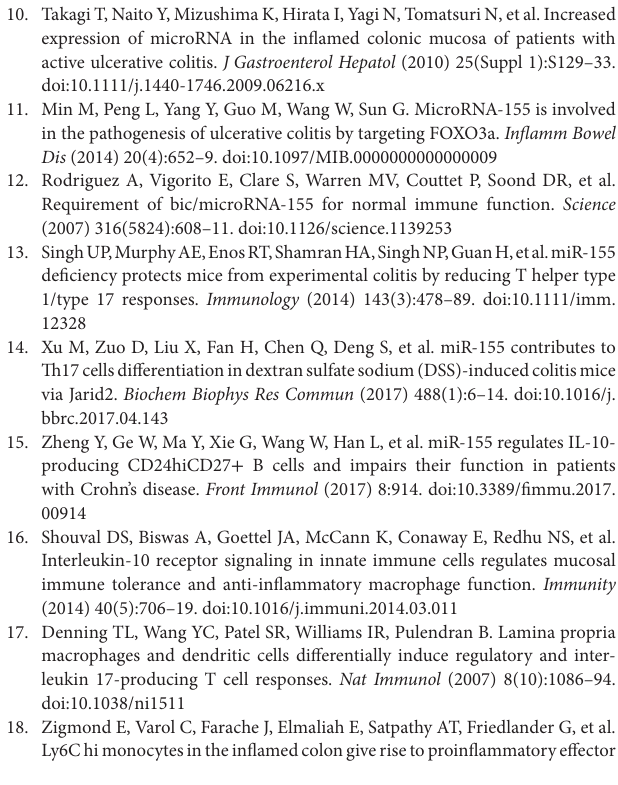
FigUre s6 | Confirmation of bone marrow chimeric mice reconstitution. PBMCs of the chimeric mice stained with anti-CD45.1-APC (for WT mice) and anti-CD45.2-FITC (for miR-155 − / − mice) detected by FACS. WT, wild-type. FigUre s7 | The representatives picture of colon length of bone marrow chimeras mice.